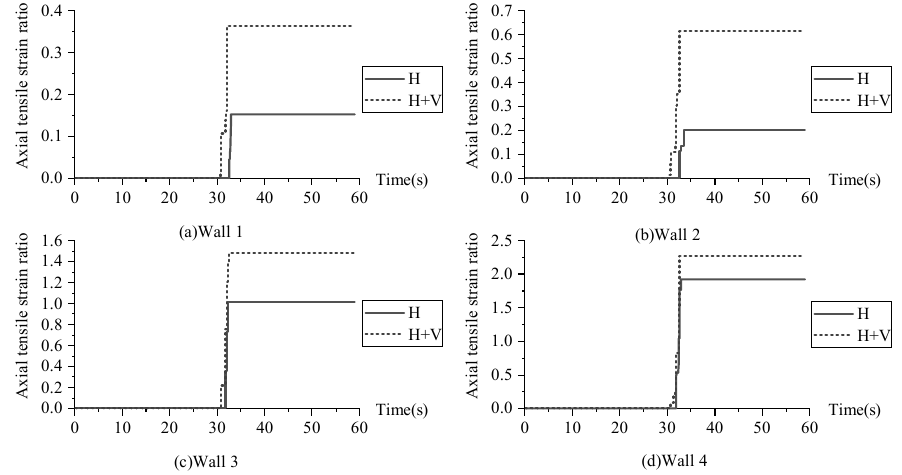
Figure 14. Time history of axial tensile strain ratio of four wall elements under two conditions of